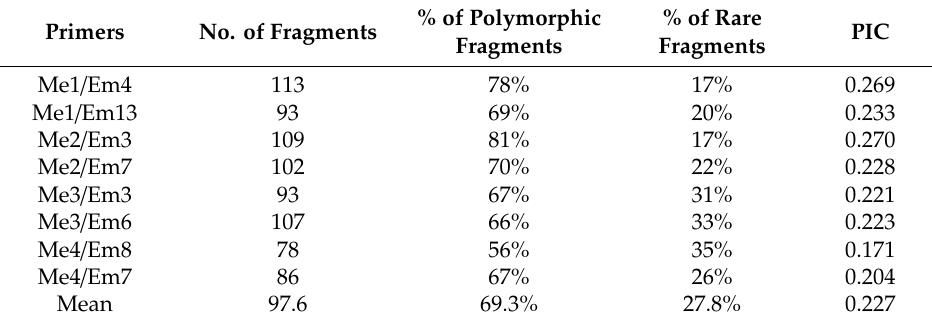
Table 4. Marker statistics (PIC, Polymorphism Information Content).